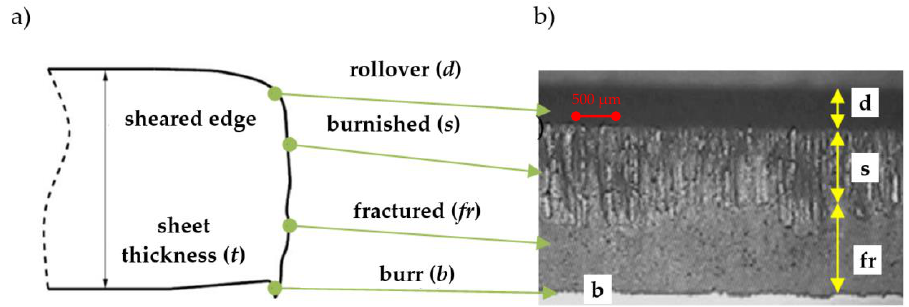
Figure 6. Typical sheared edge contour: ( a ) cross-sectional scheme, ( b ) the one obtained experimentally (front view).